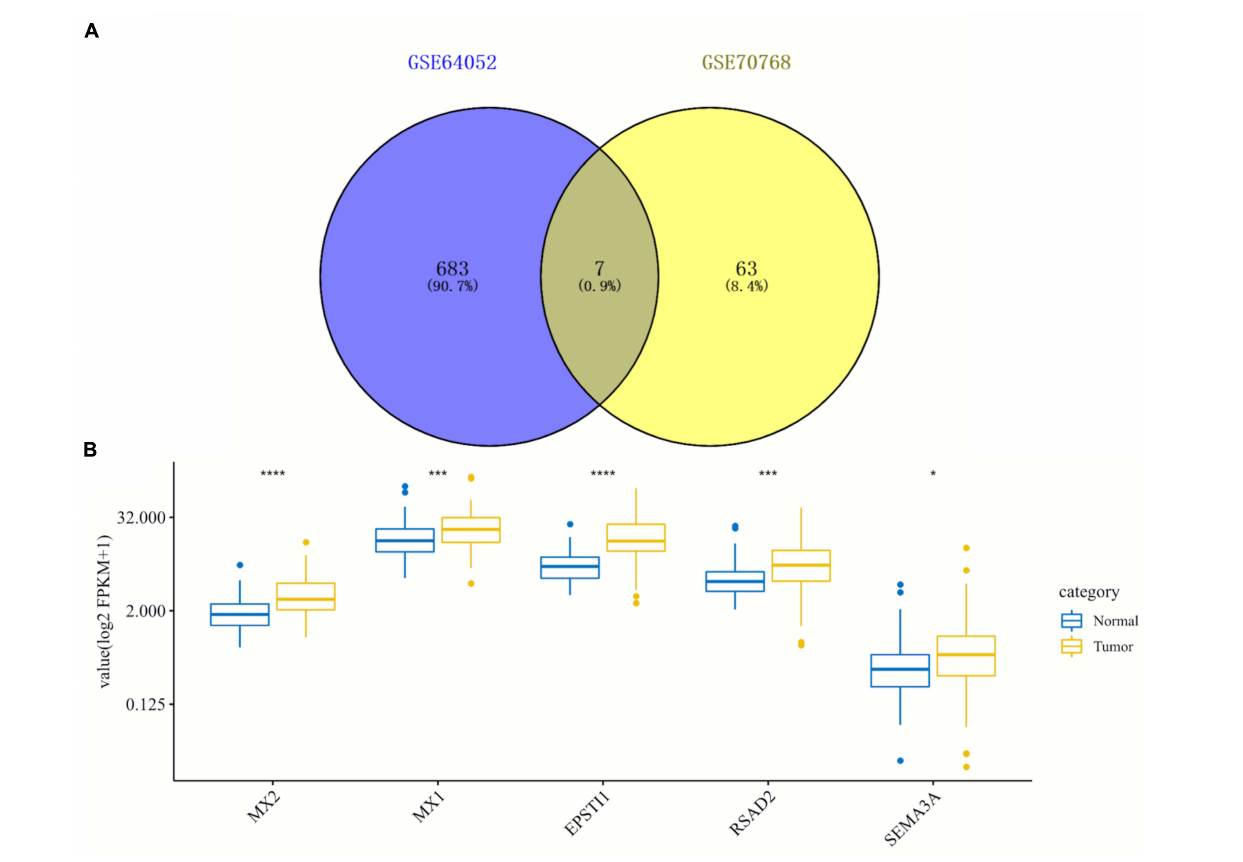
FIGURE 3 | Identification and expression analysis of five hub genes in normal/tumoral tissues. (A) Venn diagram of seven overlapping genes by comparing differentially expressed genes (DEGs) from two datasets. (B) Box plot of expression of five hub genes in normal and tumoral tissues in TCGA database. DEGs, differentially expressed genes; TCGA, The Cancer Genome Atlas. * p < 0.05; *** p < 0.001; **** p <